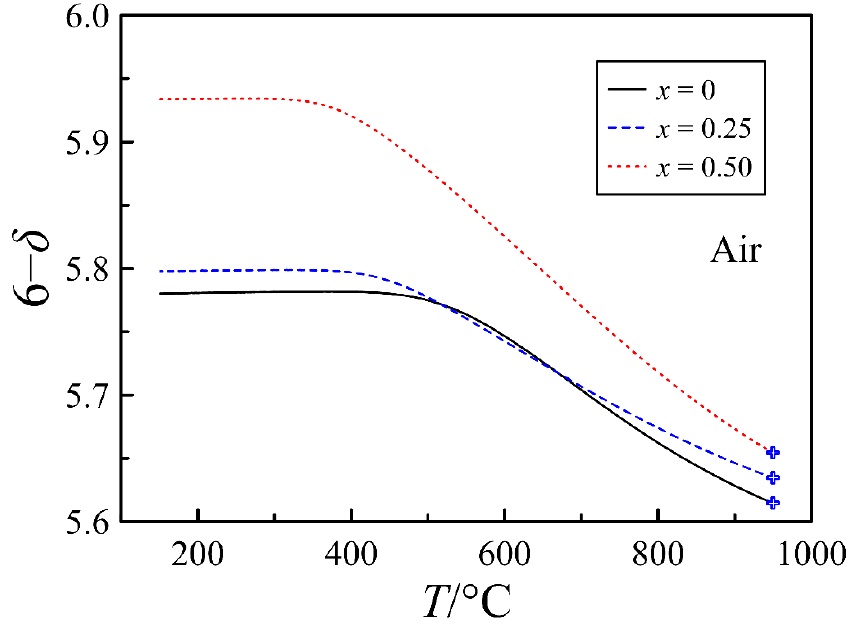
Figure 7. Oxygen content in PrBa 1− x Sr x Fe 2 O 6− δ versus temperature, calculated from thermogravi- metric results in air. The cross-like symbols indicate reference values of oxygen content taken from the data in Figure 6.